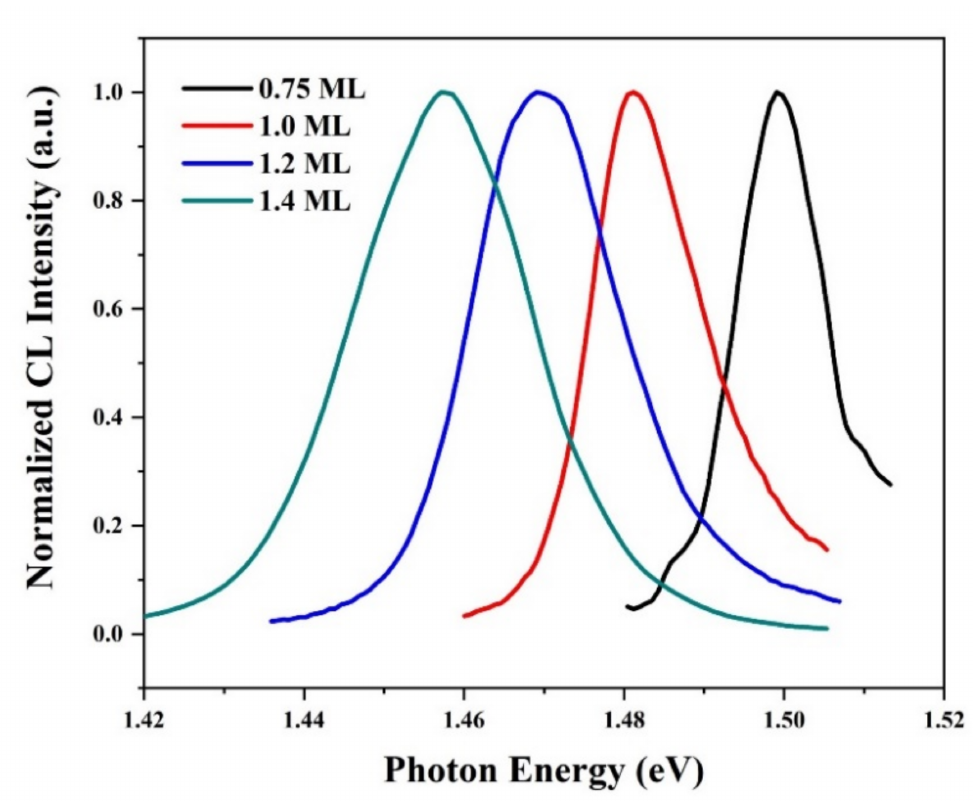
Figure 5. Normalized CL emission peaks of ultrathin quantum structures with 0.75 ML, 1.0 ML, 1.2 ML, and 1.4 ML InAs layers, respectively. All CL spectra are acquired with an identical beam energy of 10 keV at 80 K.